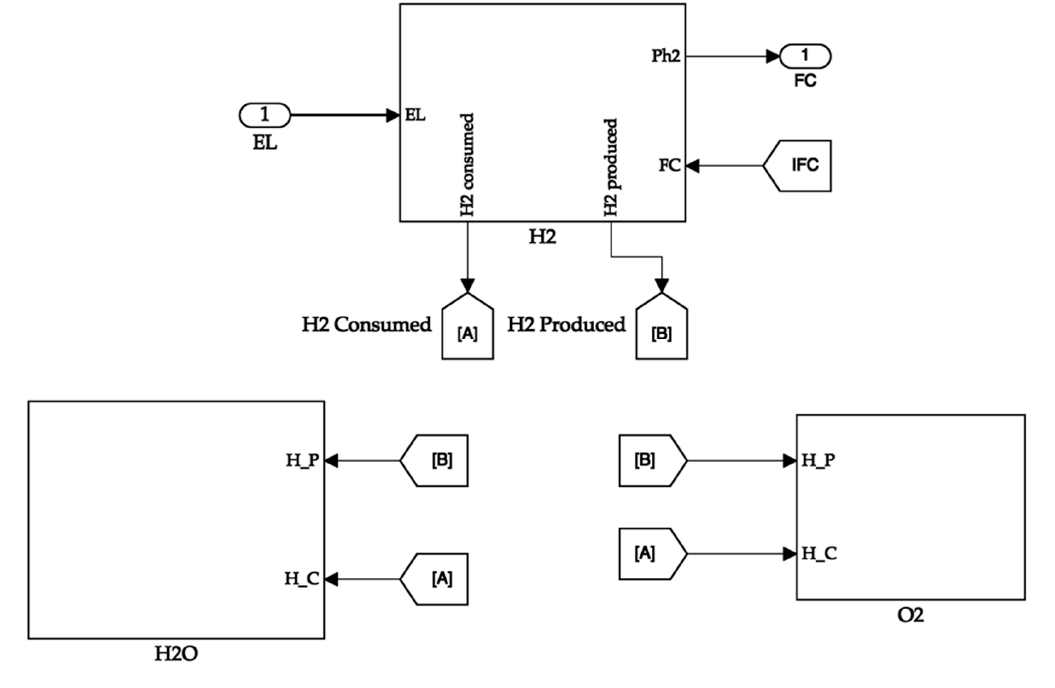
Figure 8. Storage tank system.